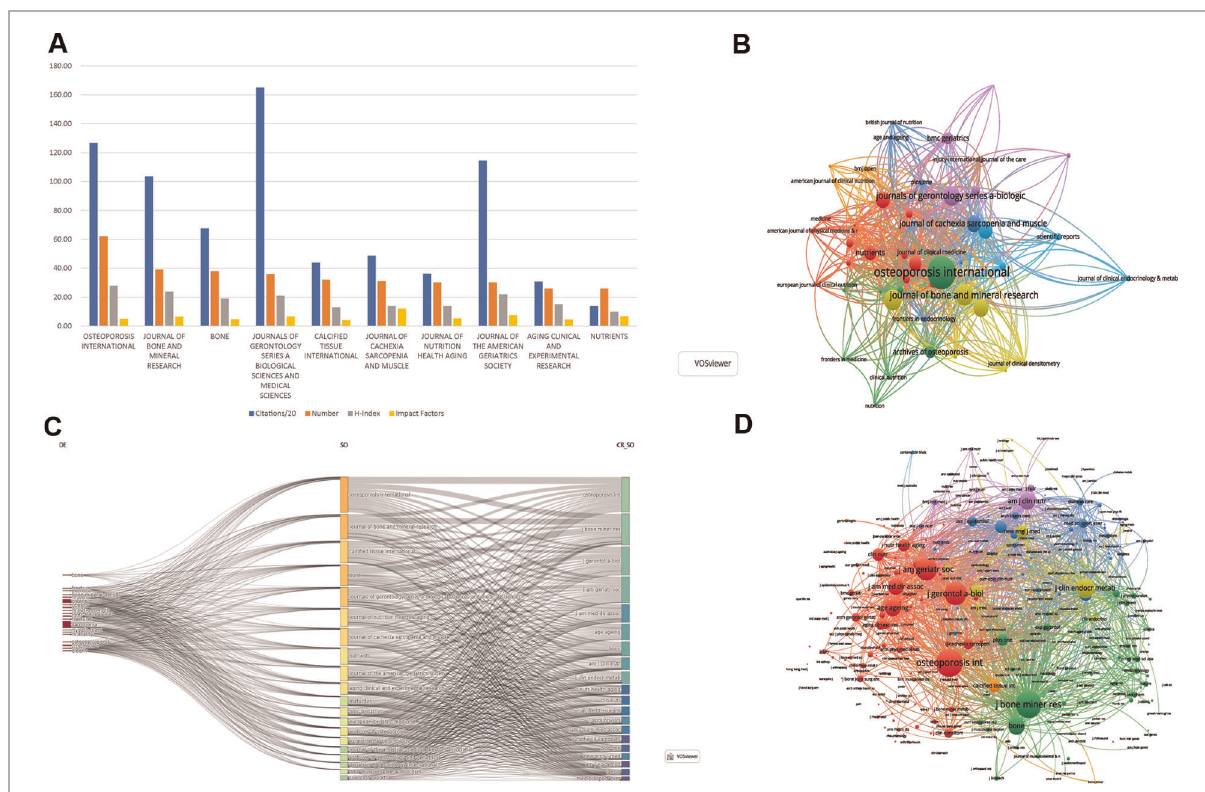
FIGURE 3 Analysis of journals and co-cited journals. ( A ) The general information of top 10 productive journals that published studies about sarcopenia and hip fractures in older patients; ( B ) network visualization map of journals that cited each other (generated by VOSviewer). The size of nodes is proportional to the cited times of journals. The thicker the lines between two nodes, the higher the frequency of their citation; ( C ) relationships between keywords, journals, and cited journals; ( D ) network visualization map of co-cited journals (generated by VOSviewer). The size of nodes is proportional to the co-cited times of journals. The thicker the lines between two nodes, the higher the frequency of their